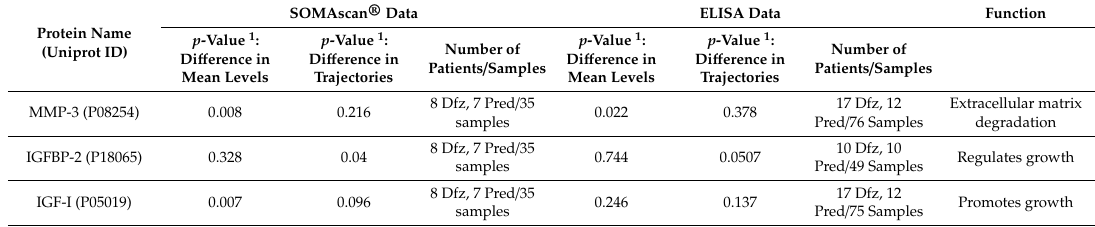
Table 4. Summary for biomarker signal confirmation using